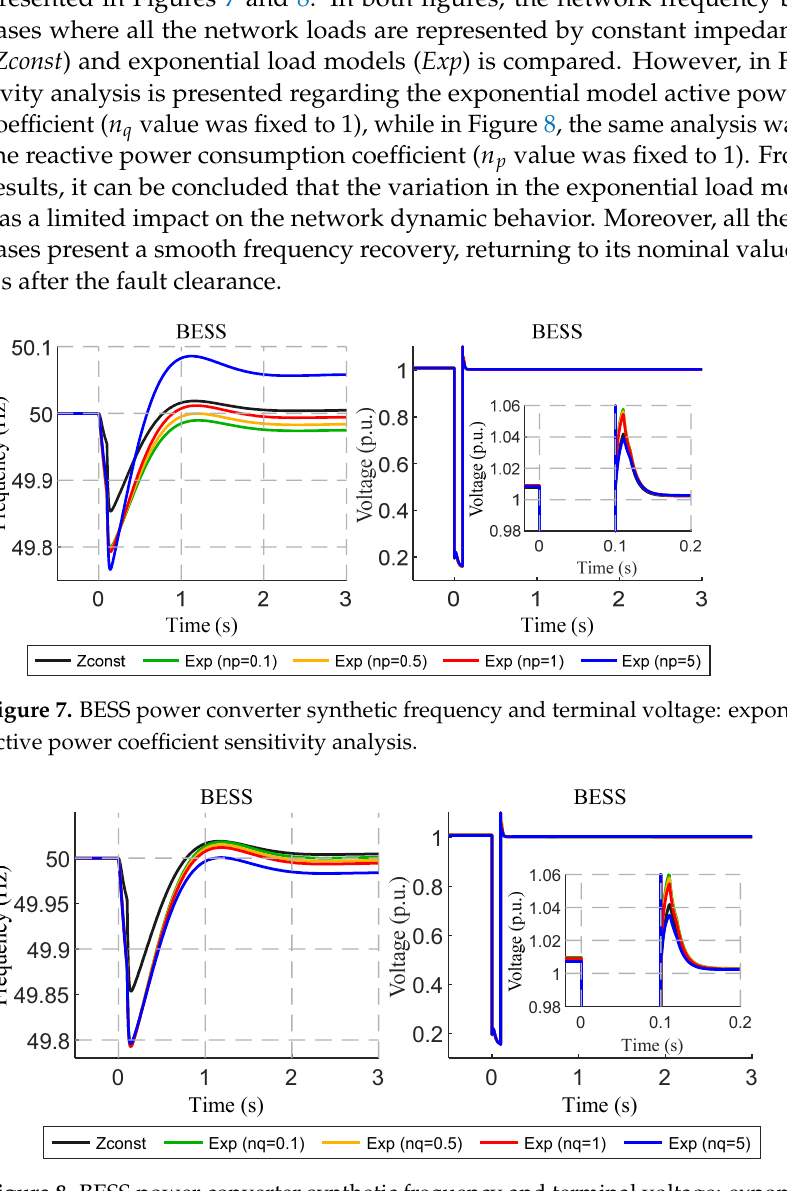
Figure 8. BESS power converter synthetic frequency and terminal voltage: exponential load model reactive power coefficient sensitivity analysis.